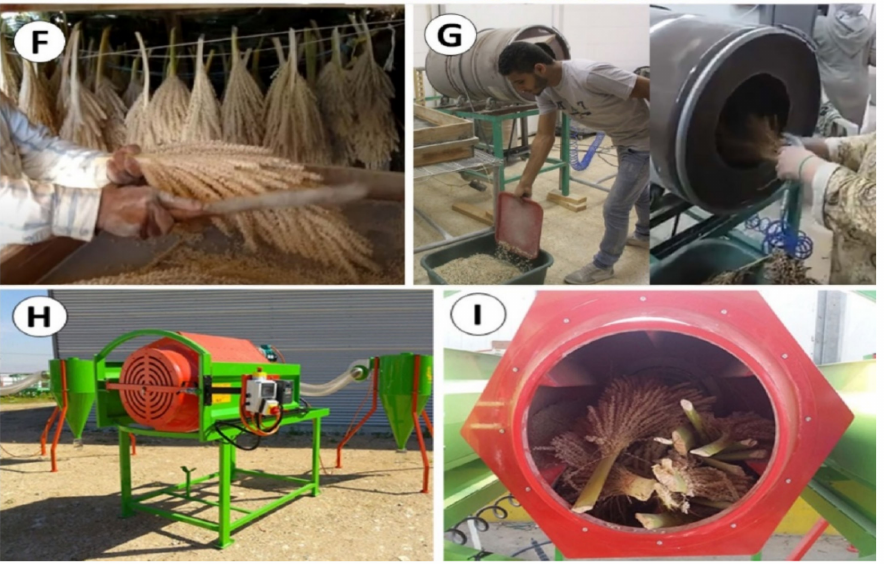
Figure 3. Date palm pollen extraction process. ( A ) Spathe about to open on the palm. It is common to tie and press the spathe with string so that it matures as long as possible on the palm. ( B ) The base of the spathe comes off, indicating that this spathe is ready to be cut. ( C ) Open spathe, ready to dry. ( D ) Hanging spathes, drying and releasing pollen grains. ( E ) Spathes on a layer of paper. ( F ) Lightly striking the inflorescence to release more pollen. ( G ) Pollen extraction machine, handcrafted. ( H , I ) In- dustrial and automated equipment for the extraction of pollen. Source: Images A, B, and C (Photos by Ricardo Salom ó n-Torres). Images D, E, F, and G (Adapted from [16,48]). Images H, I (courtesy of Agrom Agricultural Machinery, LTD, www.agrommachine.com; accessed on 22 July